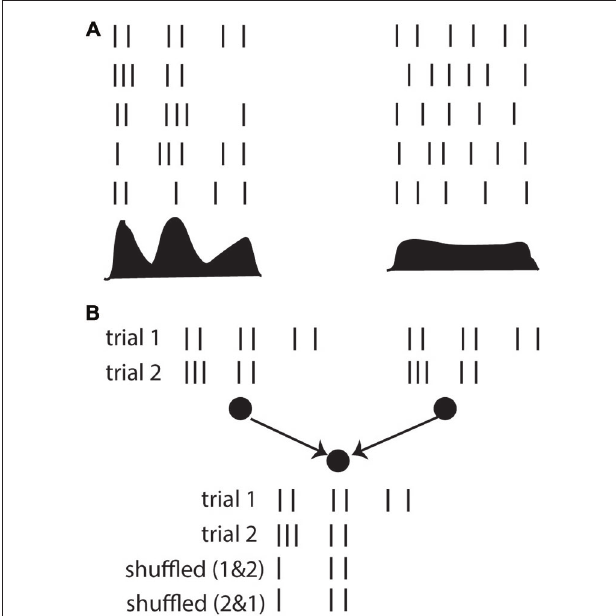
FIGURE 4 | The timescale argument . (A) Responses of a neuron over repeated trials, where the firing rate (PSTH shown below) varies on a fast (left) or slow (right) time scale. (B) Whether the firing rate varies quickly or slowly, the average rate is not generally sufficient to predict the response of a postsynaptic neuron. Here the responses of two neurons are shown over two trials. The postsynaptic neuron responds strongly when the presynaptic spike trains are taken in the same trial (because they are synchronous), but not if the spike trains are shuffled over